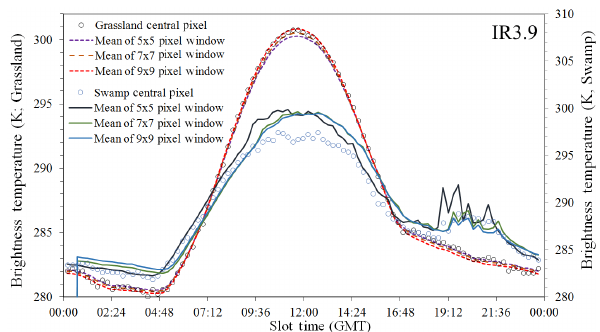
Figure 9. Demonstration of the ability to estimate the SEVIRI IR3.9 (MWIR) brightness temperature of the central pixel in a 5 × 5, 7 × 7 and 9 × 9 pixel window using the mean of the remaining “back- ground window” pixels. Results for two different land cover types are shown from the GLC2000 database: grassland (plotted on left- hand y axis) and swamp (plotted on right-hand y